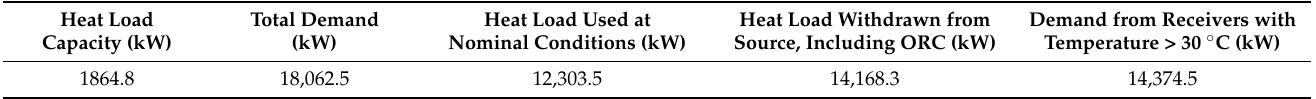
Table 7. Heat flux balance for the proposed process line and comparison with